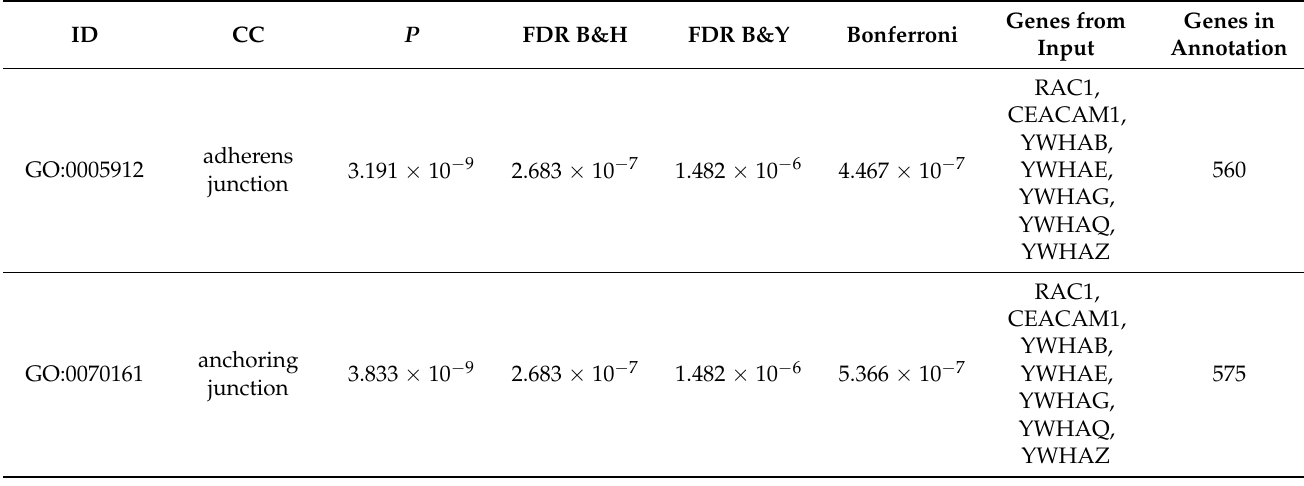
Table 3. The top 5 annotations of the ToppFun FEA for CC